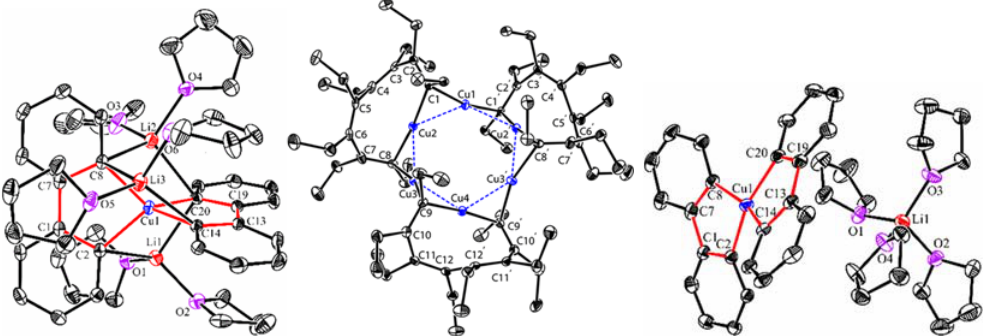
Figure 1. Molecular structures of 4 , 5 , and 7 . Reprinted with permission from [59,60]. Copyright 2017 and 2018 American Chemical Society.